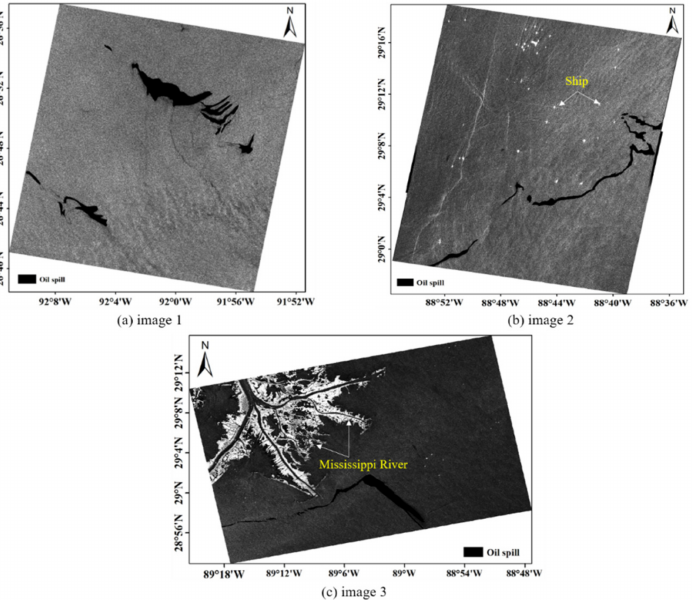
Figure 3. The oil spill images of RADARSAT-2 in the quad-polarization imaging mode used in this study: ( a ) oil spill image of image 1; ( b ) oil spill image of image 2; and ( c ) oil spill image of image